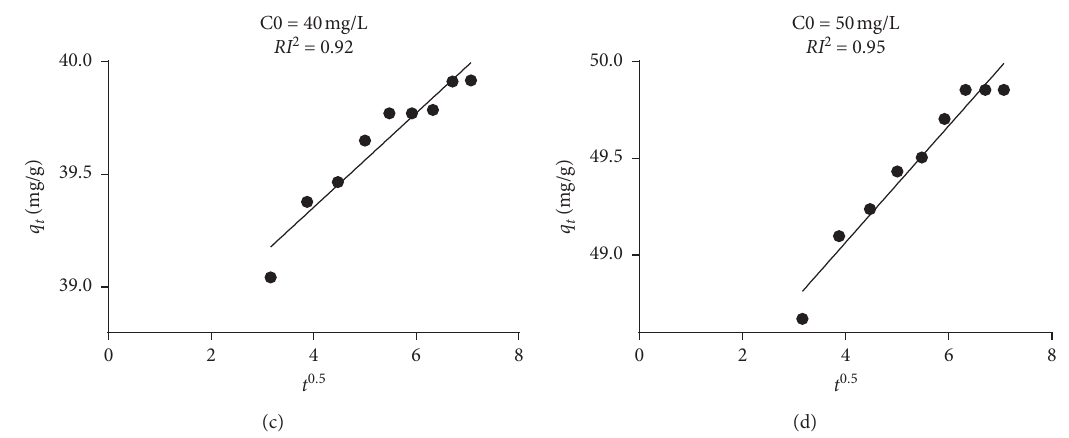
Figure 9: Intraparticle diffusion mechanism for different initial